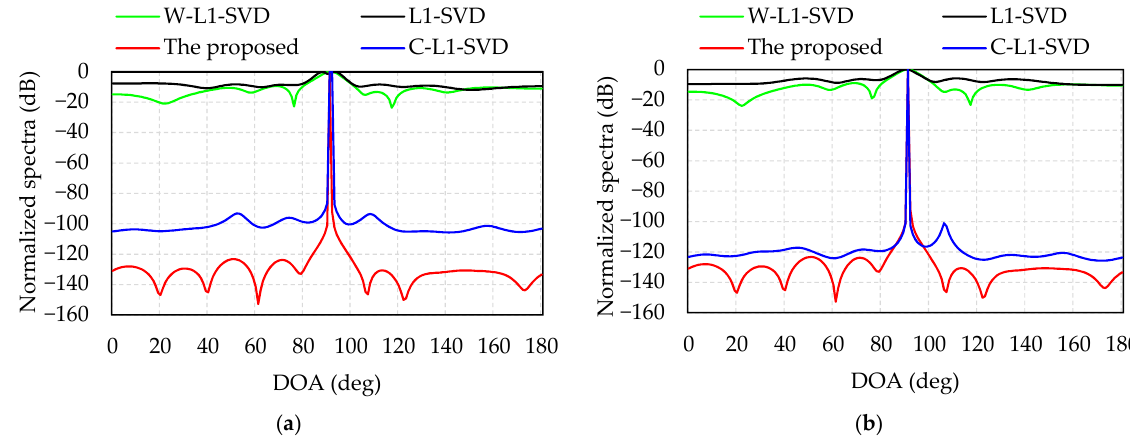
Figure 10. Normalized spectra during the measurement of outdoor scenario when the incident angle is 90°: ( a ) the SNR of emission signal is 0 dB; ( b ) the SNR of emission signal is 15 dB.